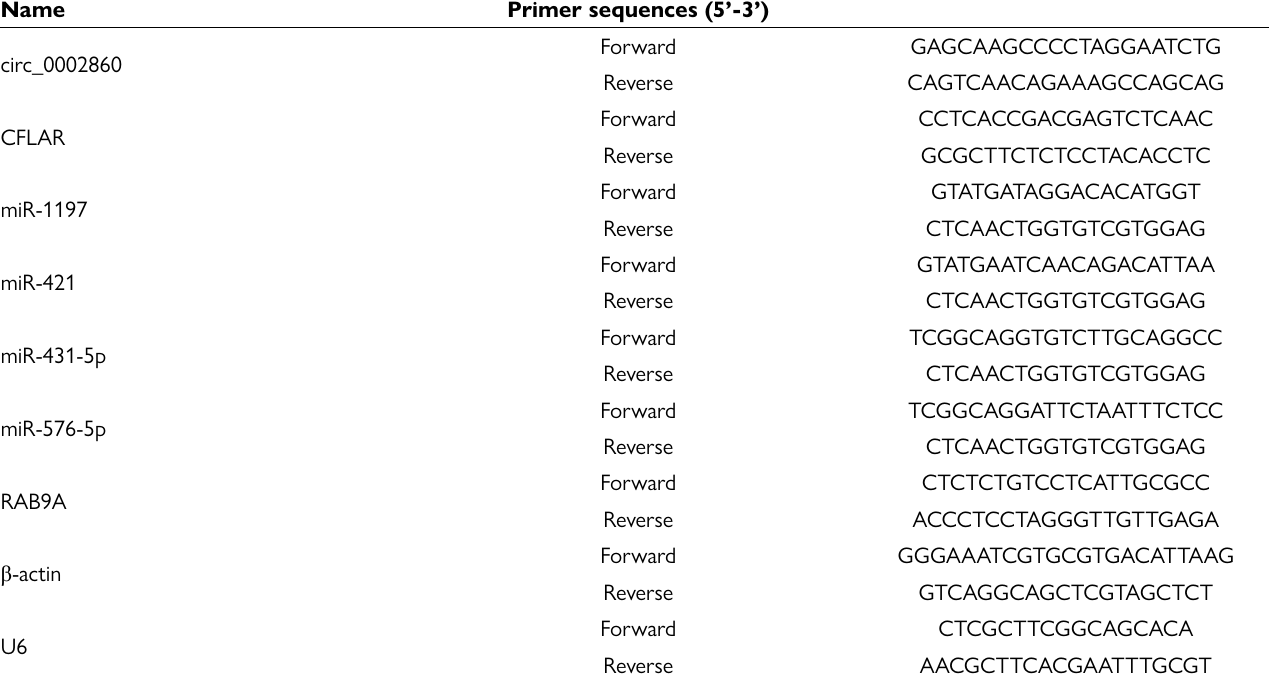
Table 1. Primer sequences used for